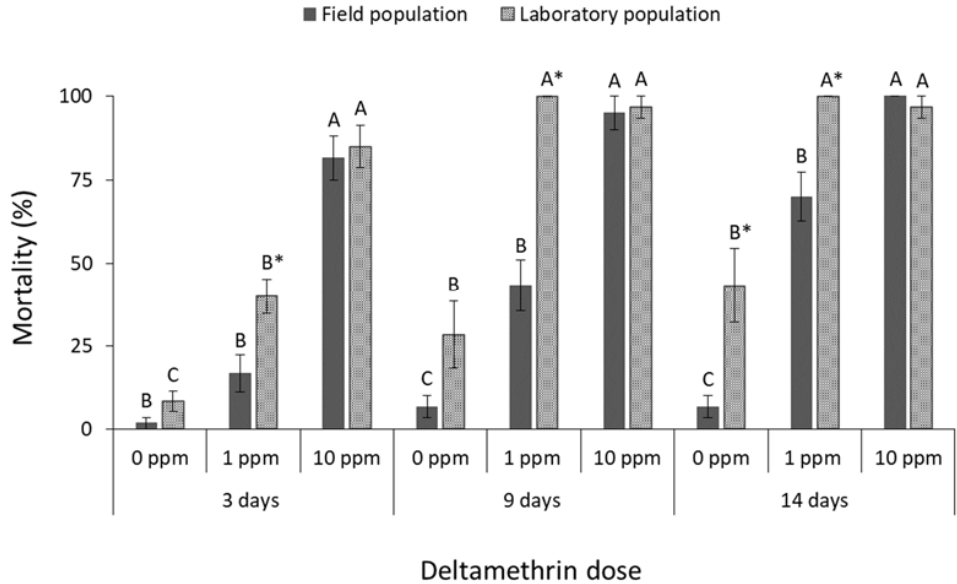
Figure 7. Mean (% ± SE) adult mortality of field and laboratory populations of C. ferrugineus after 3, 9 and 14 days of exposure to different concentrations of deltamethrin (within each exposure interval and population, means followed by the same letter are not significantly different; where no letters are present, no significant differences were noted; HSD test a 0.05; within each exposure interval and dose, means with asterisk (*) indicate significant differences between the populations, according to Students’ t –test at p < 0.05).